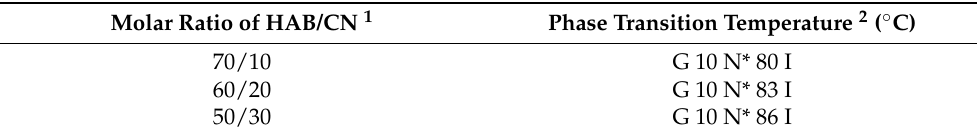
Table 3. Phase transition temperatures of N* LC (2.0) elastomers with different HAB/CN